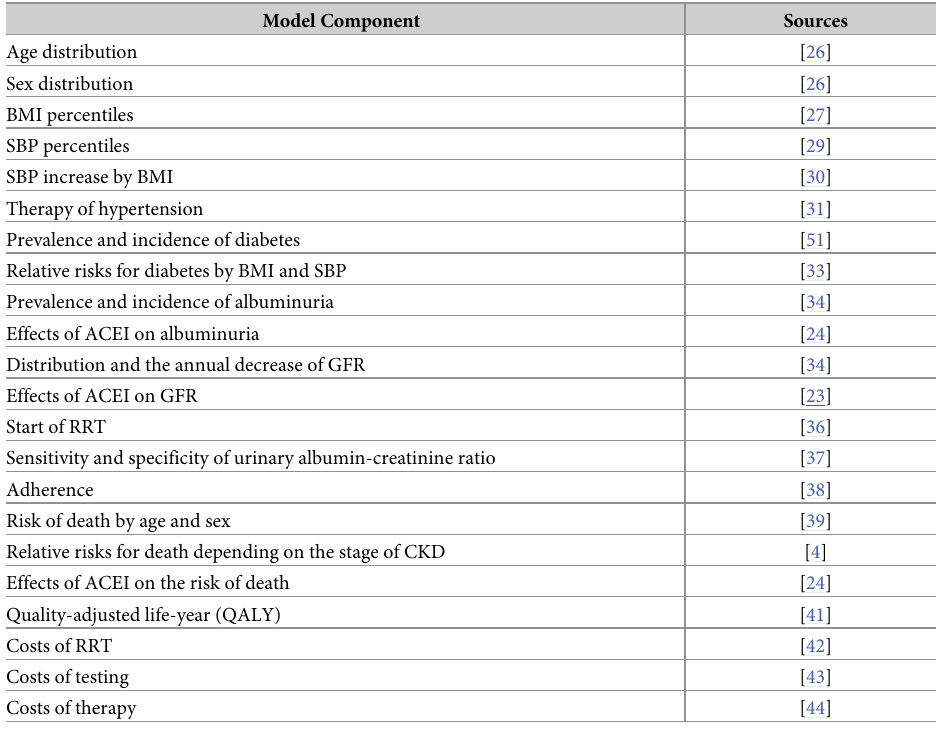
Table 1. Overview of model components and related sources of